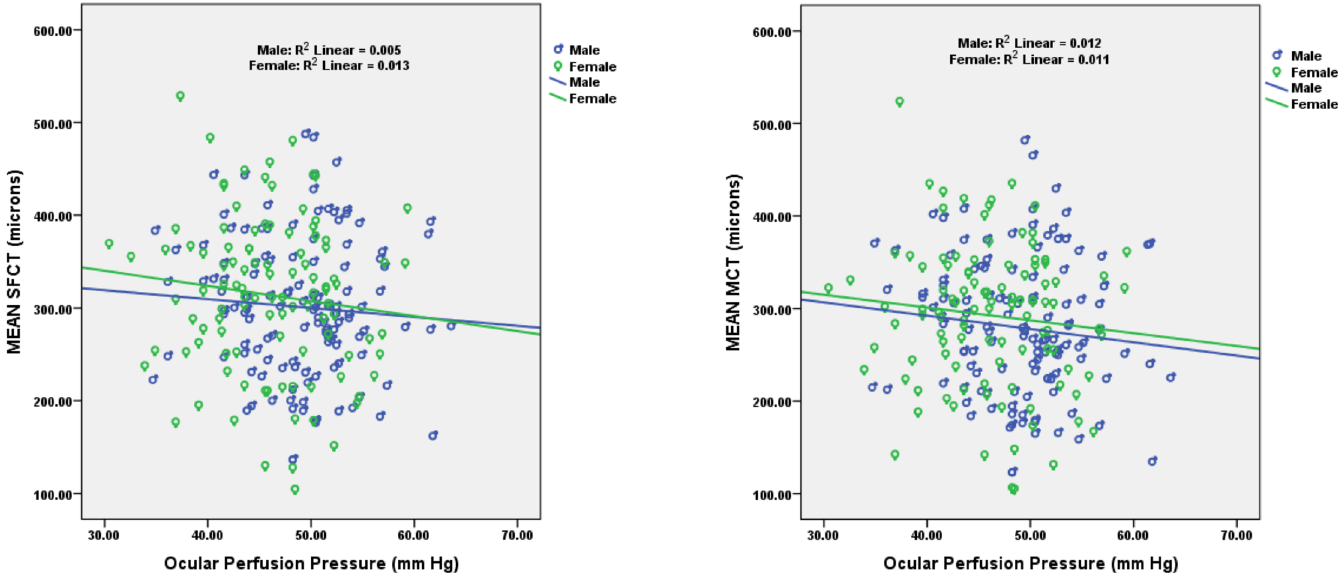
Fig 7. Scatter plot showing the correlation between ocular perfusion pressure and SFCT (left) and MCT (right).